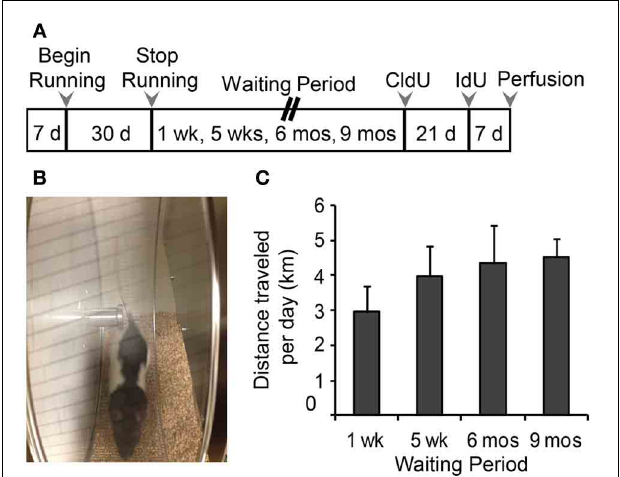
FIGURE 1 | (A) Experimental time line. Male, Long Evans rats were 28 days old at the beginning of the study. Animals were divided into Runners (unlimited wheel access for 30 days) and Controls (non-runners). Four separate batches of Runners and Controls were perfused 1 week, 5 weeks, 6 months, and 9 months following the running period. Animals in the 1 week batch were injected with CldU only, at 7 days prior to perfusion. All remaining batches were injected with CldU at 4 weeks prior to perfusion, and with IdU at 7 days prior to perfusion. (B) Photograph of a 4 week old Male Long Evans rat on the running wheel apparatus. (C) Summary of running behavior (average daily running distance in km; mean ± s.e.m.) for all four batches. ANOVA showed no significant differences in the distance per day between Running cohorts (ANOVA, P = 0 .